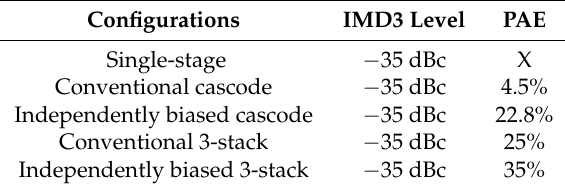
Table 4. Summary of linearity and efficiency